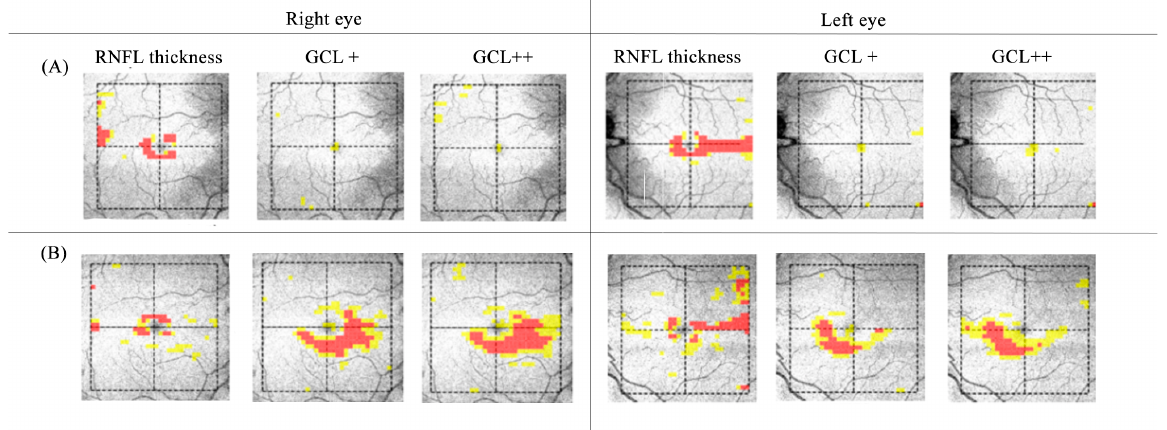
Figure 2. Retinal ganglion cell layer thinning revealed by optic coherence tomography (Topcon) at presentation ( A ) and after five months ( B ).